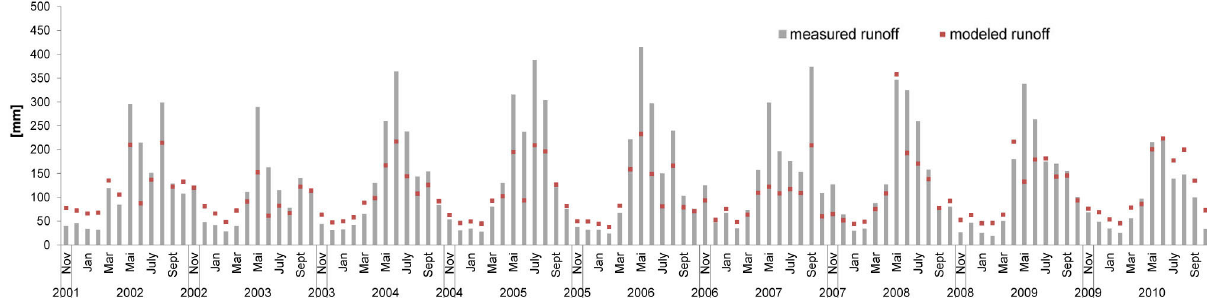
Fig. 9. Monthly sums of measured runoff and modeled runoff in subbasin K¨onigsseetal before ANN correction –for years 2001 to